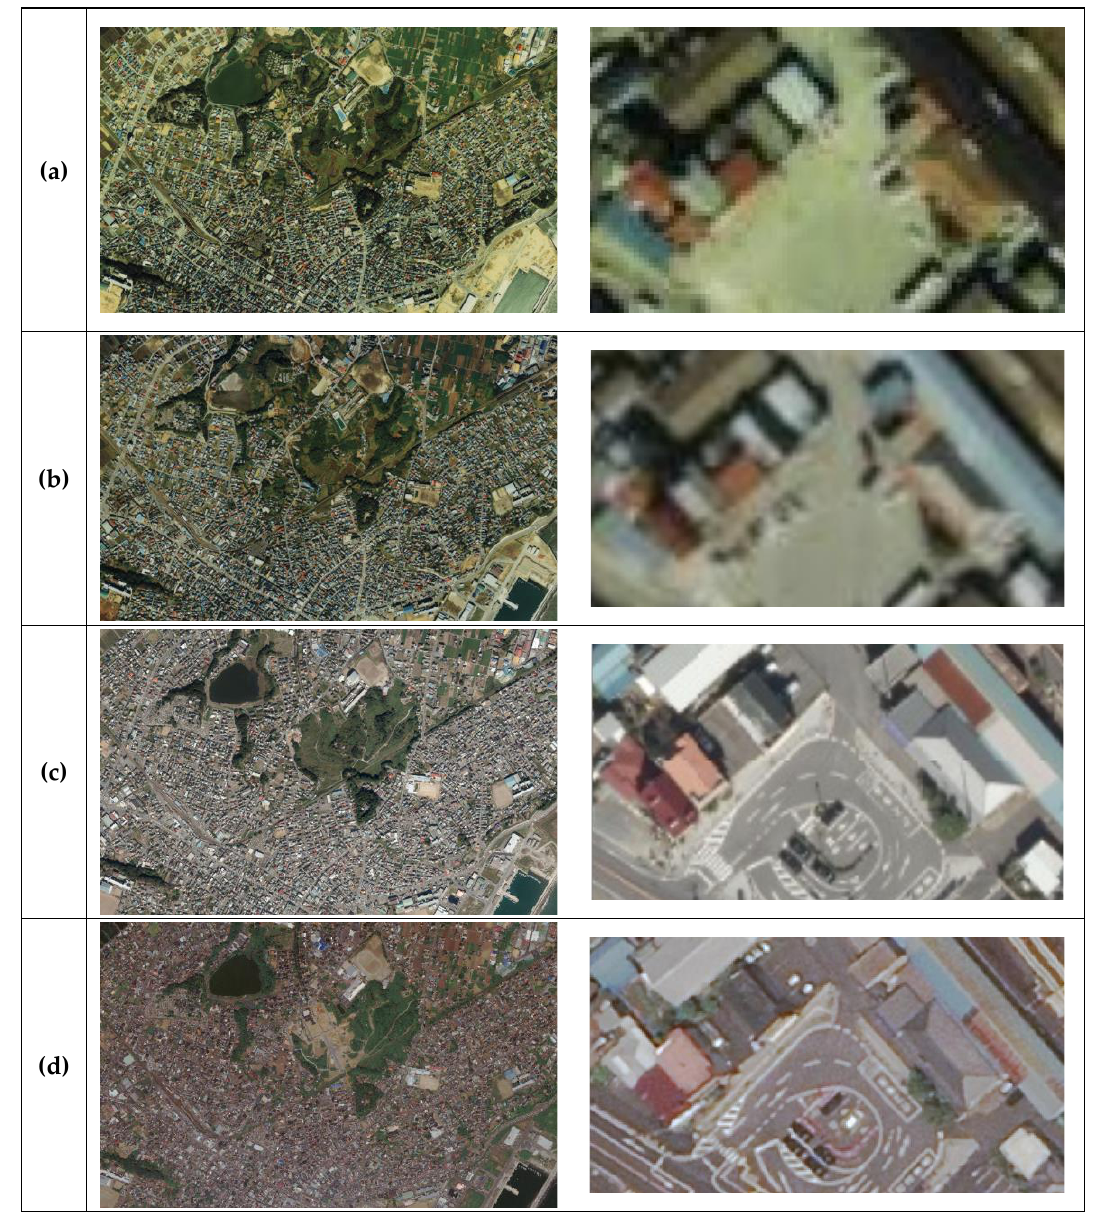
Figure 4. Images of entire Hitachinaka area and enlarged images cropped around Nakaminato Station: (a) old-period aerial photo 1, (b) old-period aerial photo 2, (c) new-period aerial photo and (d) WV-3 image.